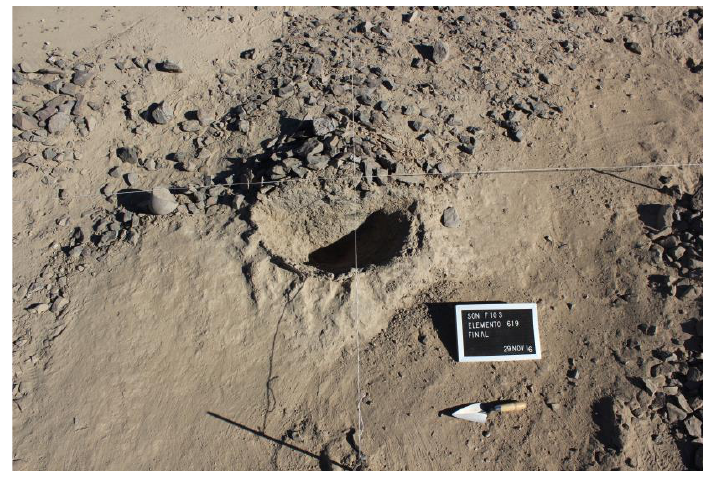
Figure 3. Remains of combustion feature (kiln or horno